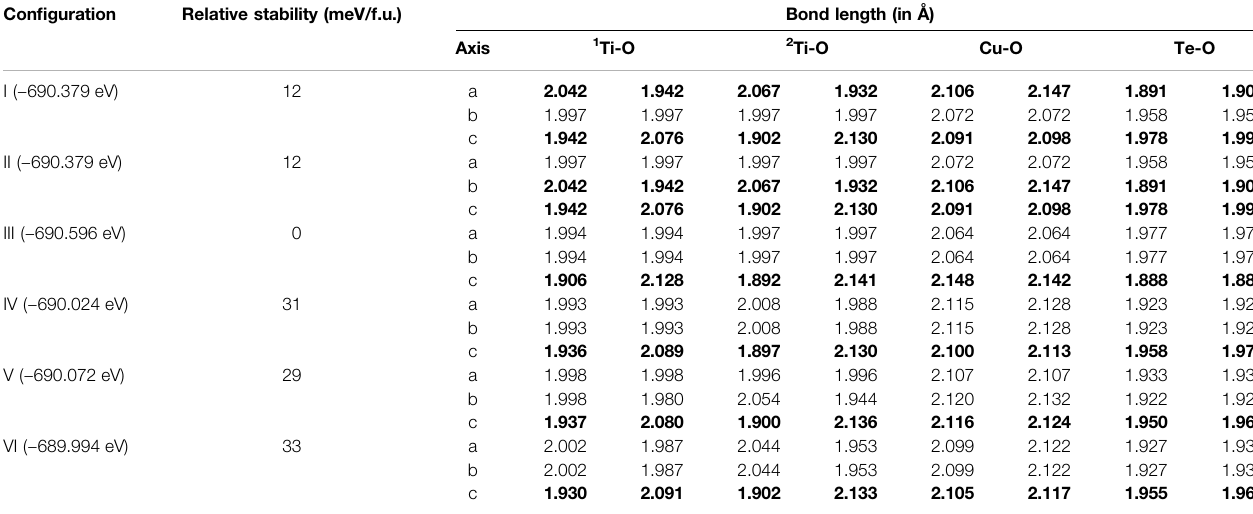
TABLE1| EnergiesandmetaloxygenbondlengthsintheMO 6 octahedraforgeometryoptimizedDFTcalculationsforallsixcon fi gurationsofBaTi 1-x (Cu 1/2 Te 1/2 ) x O 3 withx (cid:2) 0.11. The axes having the largest off centering distortion in Ti-O bond lengths have been highlighted in bold. Con fi guration Relative stability